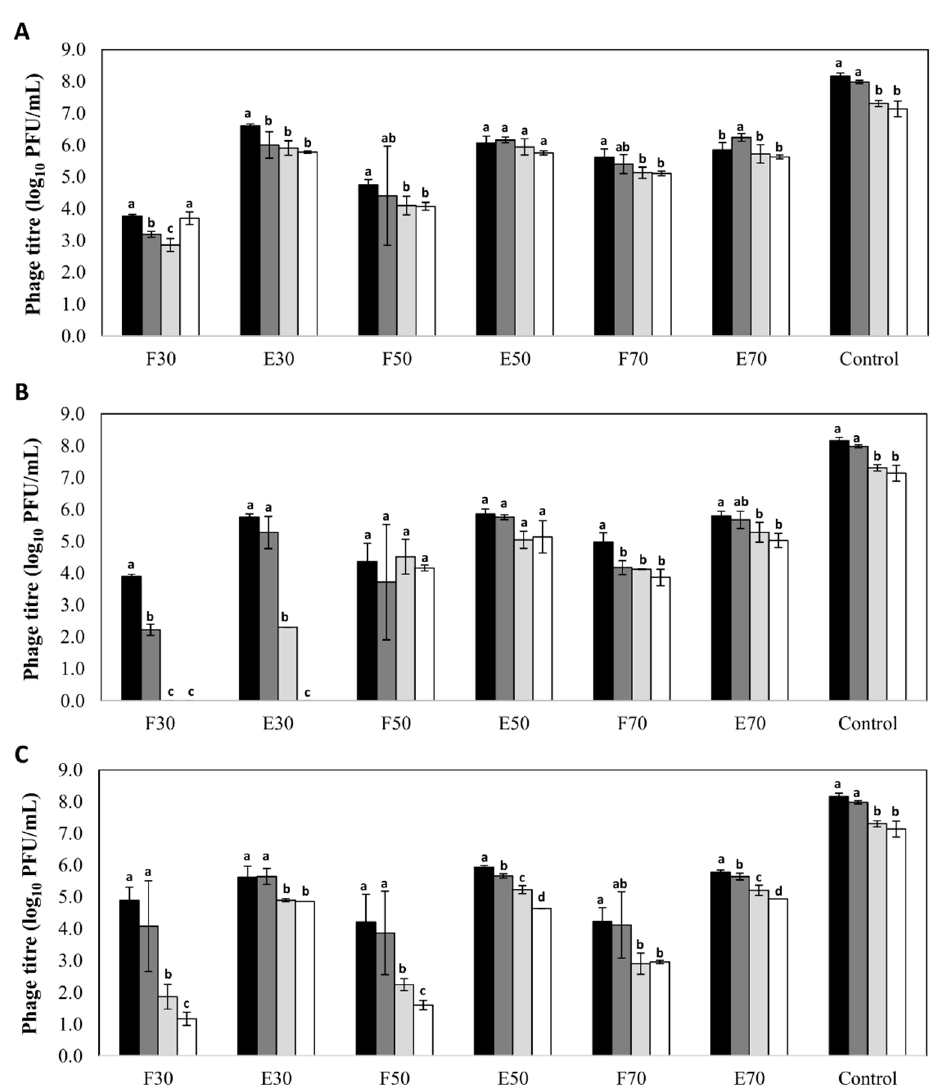
Figure 1. Stability (log 10 PFU/mL) of bacteriophage phiIPLA-RODI encapsulated in different types of nanovesicles and in SM buffer (control), after storage at 4 ◦ C: ( A ) niosomes, ( B ) liposomes and ( C ) transfersomes. Phage titer was determined after encapsulation (black bars) and also after storage for 2 months (dark grey bars), 4 months (light grey bars) and 6 months (white bars). (F): non encapsulated or free phage; (E): encapsulated phage. Numbers (30, 50 or 70) indicates the concentration of components expressed in mg/mL. Bars represent mean ± standard deviation of three biological replicates. Different letters indicate differences in stability ( p < 0.05; ANOVA and SNK post-hoc comparison).